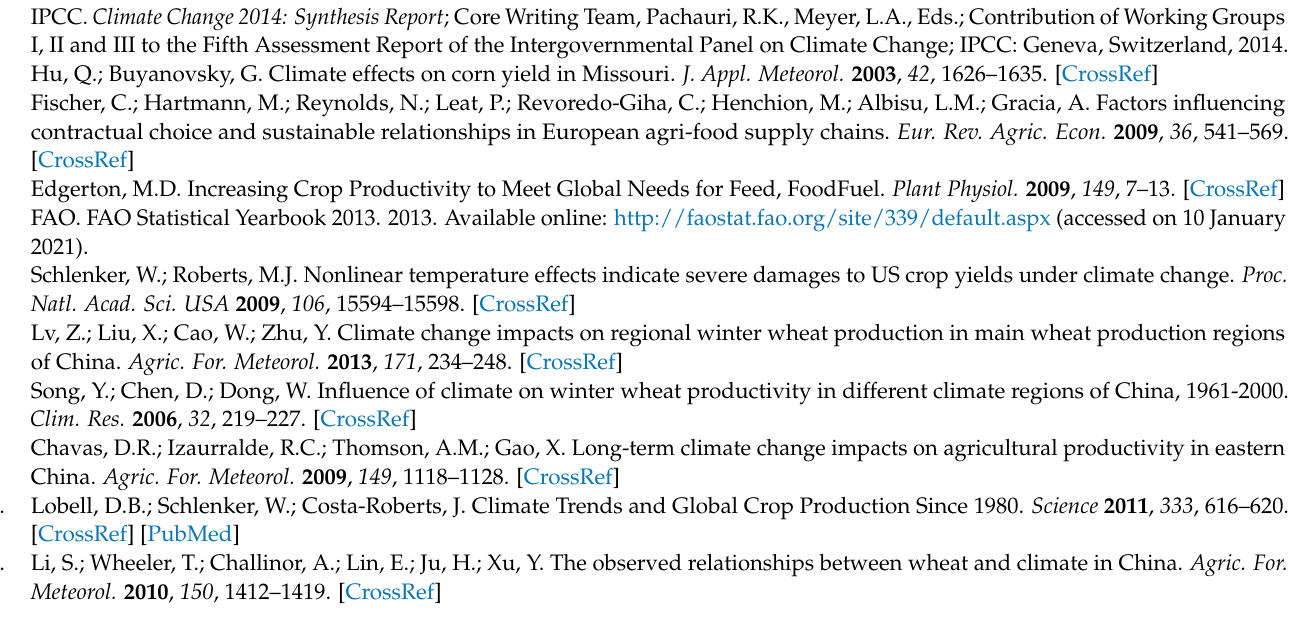
Table S1: The main climatic index (1980–2010) and the initial soil properties of the three long-term experimental sites (1990); Table S2: Fertilization regimes conducted for wheat and maize cropping in the three long-term experimental